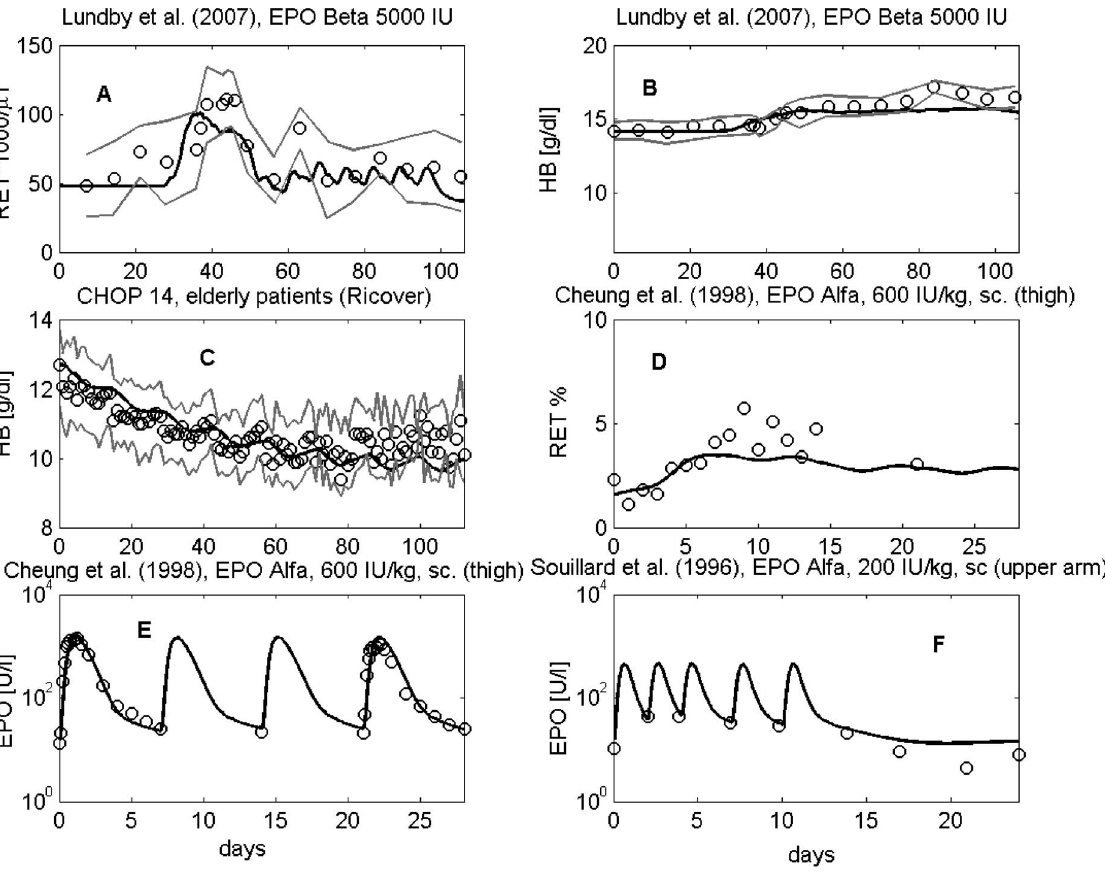
Figure 10. Validation scenarios. Reticulocytes (A) and HB (B) after multiple injections of EPO Beta (data were extracted from [32]): dots represent patient means, grey dotted lines mean + standard deviation. (C) HB under eight cycles of CHOP-14 therapy (we have access to the raw data, the study is described in [18]): dots represent patient medians, grey lines represent interquartile range of patient data. Reticulocytes (%) (D) and EPO serum concentrations (E,F) after multiple EPO Alfa injections at different subcutaneous sites [31,33]: dots represent patient means. Solid black curve represents model predictions throughout.